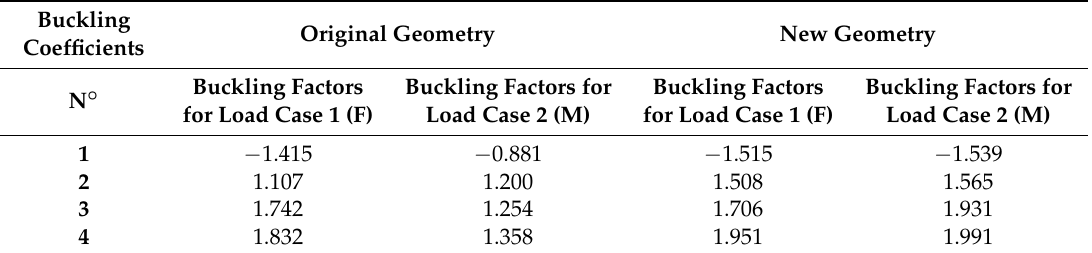
Table 6. Load buckling factors for two geometries and for two different external